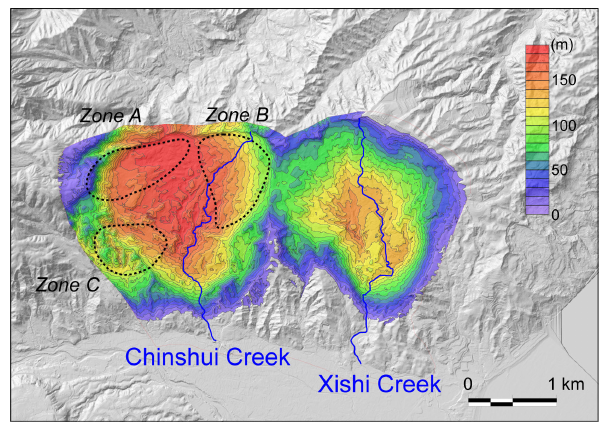
Figure 10. Isopach map of the landslides. The depleted landslide mass is calculated from the difference in height between the current and reconstructed topographies. The contour bands are shown at 10m intervals. The original ground surface is extracted from the lidar